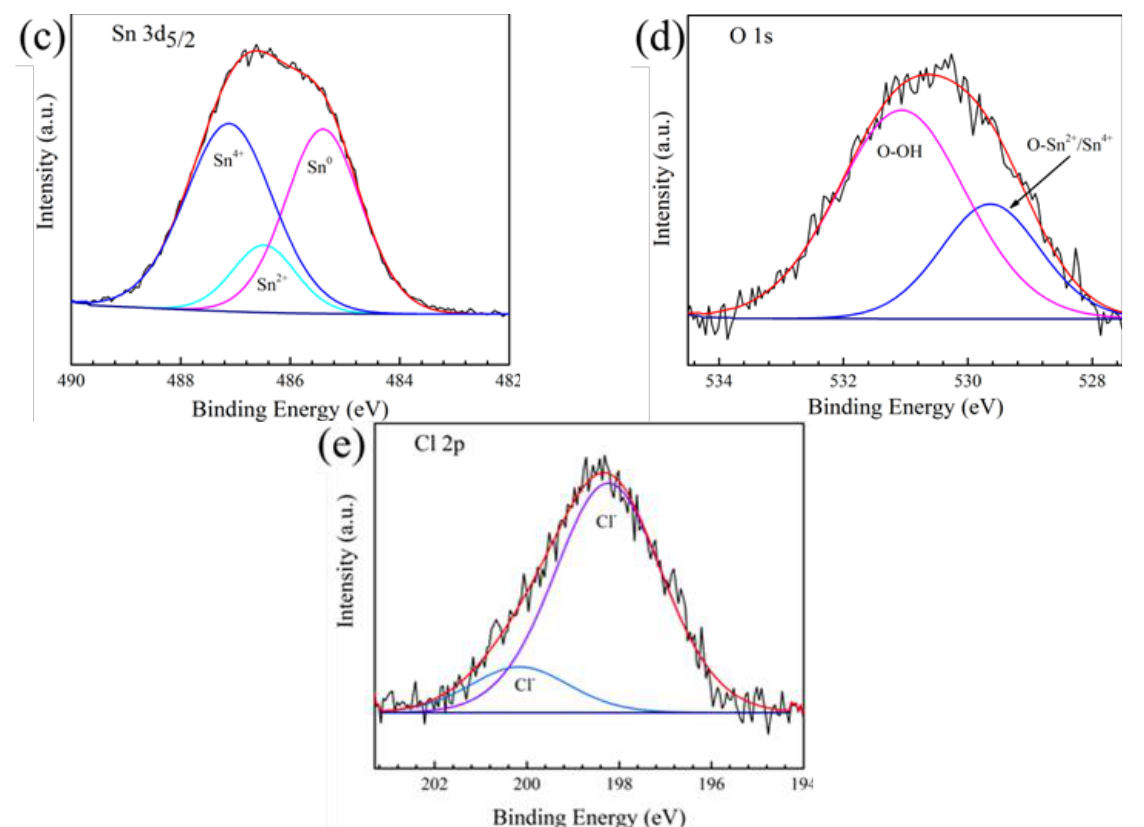
Figure 10. XRD patterns of MC Sn-20Bi- q GNSs solders after electrochemical corrosion; ( b ) XPS scan full spectrum of MC Sn-20Bi-0.02GNSs solder after electrochemical corrosion; ( c – e ) XPS fitting results of MC Sn-20Bi-0.02GNSs after electrochemical corrosion: ( c ) Sn 3d5/2, ( d ) O 1s, and ( e ) Cl 2p.